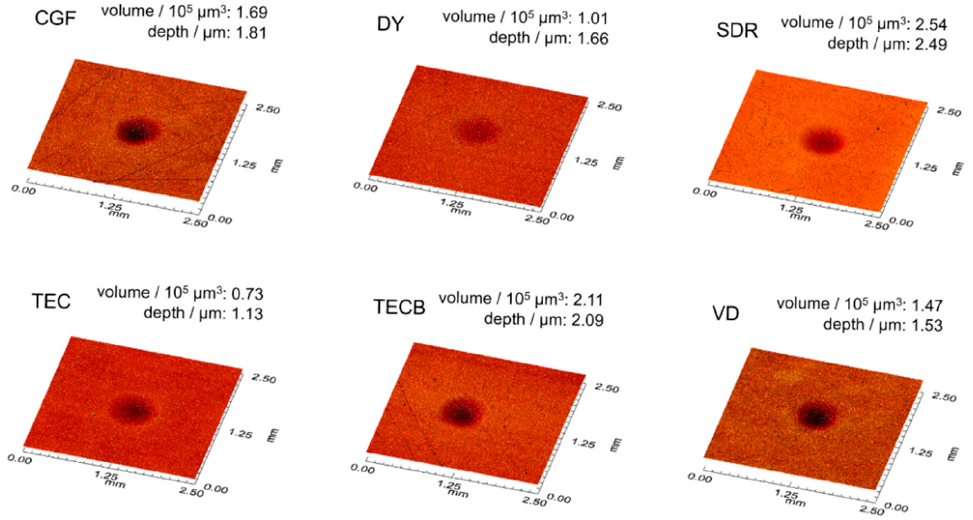
Figure 7. Representative surface topography images of Leeb hardness indentation areas. Indentation volumes and depths are displayed on the respective right upper corner of each image.